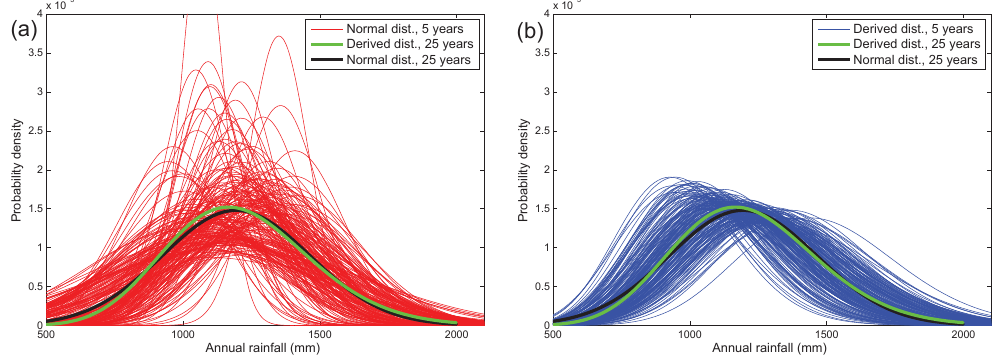
Figure 6. Estimated pdfs for 5-year subsamples using normal distributions (red, a ) and derived distributions (blue, b ) in Concepción.